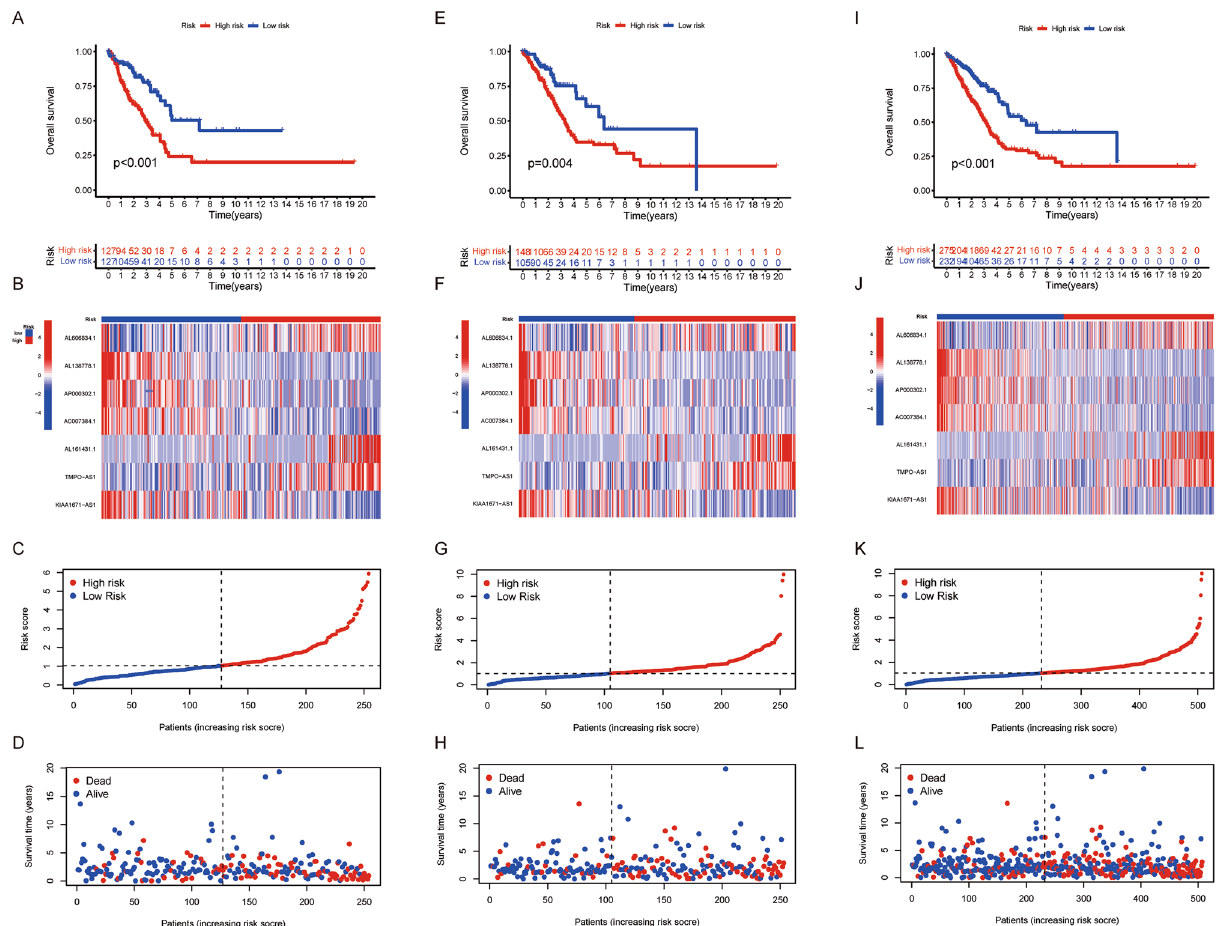
Figure 3. The correlation between the predictive signature and the prognosis of LUAD patients. ( A – D ) Training group; (E–H) Test group; ( I – L ) Total patients; ( A & E & I ) Kaplan–Meier analysisof the OS rate of LUAD patients. ( B & F & J ): Heat map showing the expression profiles of cuproptosis-associated seven-lncRNAs. (C&G&K): The distribution of the risk score among LUAD patients. ( D & H & l ): The number of dead and alive patients with different risk scores. Blue represents the number of survivors, and red represents the number of